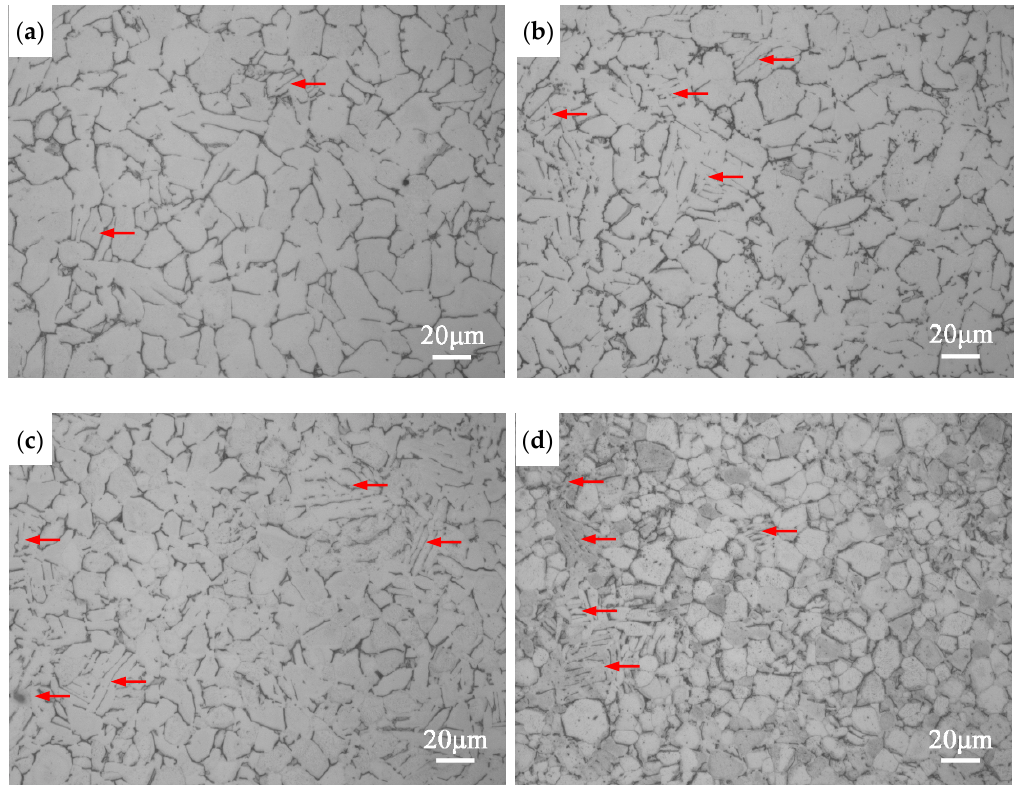
Figure 7. OM images of the composites with different addition amounts of GO ( a ) 0; ( b ) 0.15 wt%; ( c ) 0.3 wt%; ( d ) 0.5 wt%; Lamellar α were marked by red arrows. Materials 2020 , 13 , x FOR PEER REVIEW